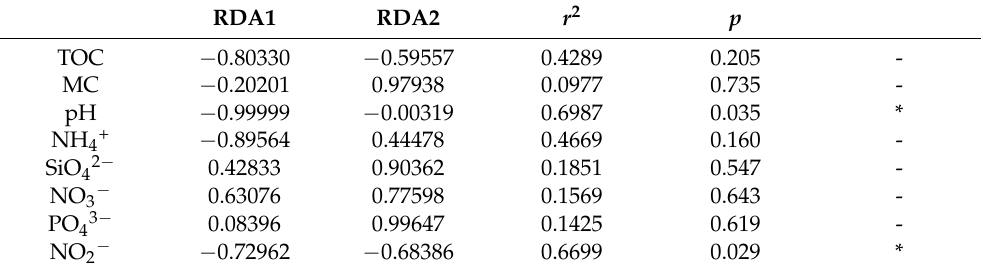
Table 3. A Monte Carlo permutation test for geochemical properties and archaeal